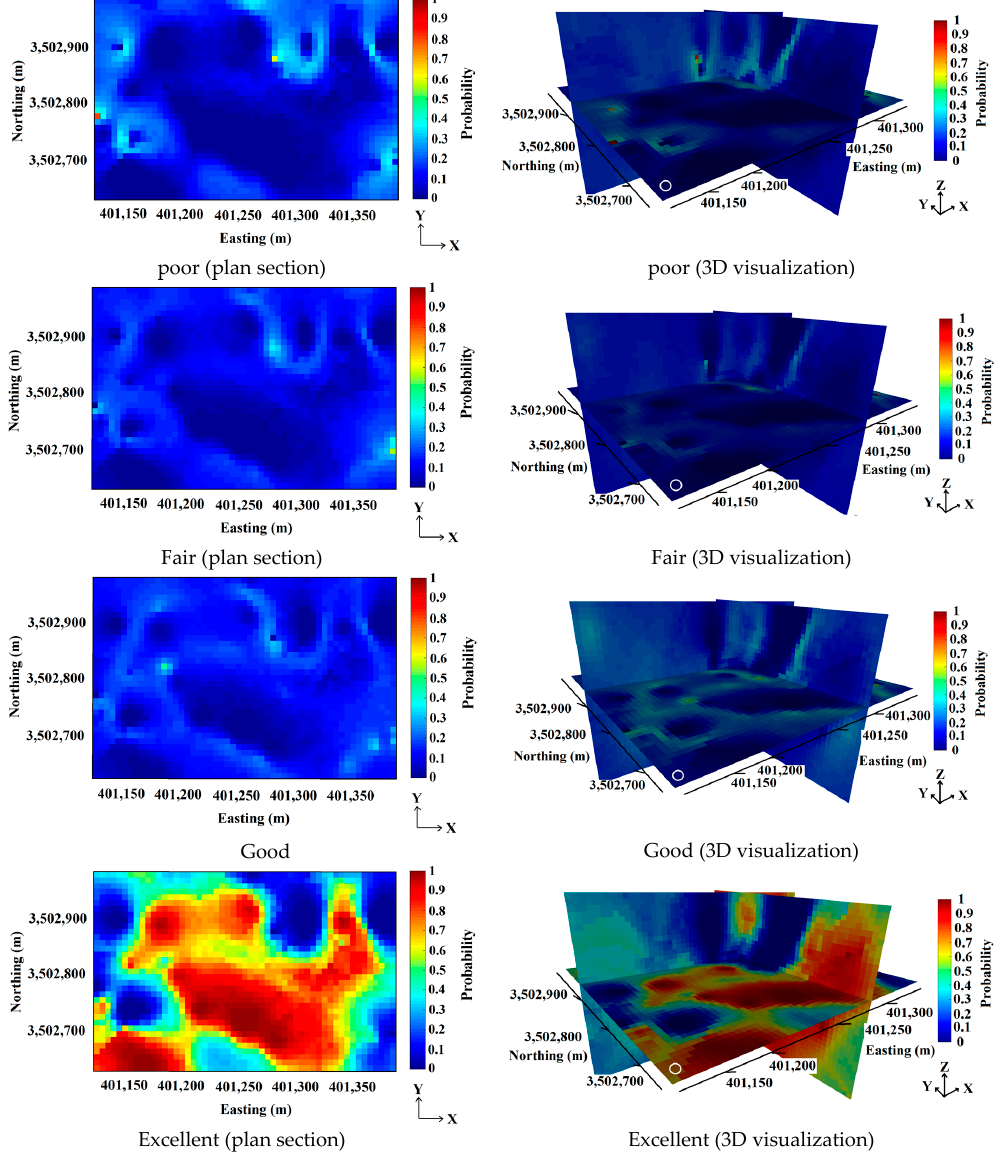
Figure 11. Probability maps for different rock mass qualities at elevation 80 m.